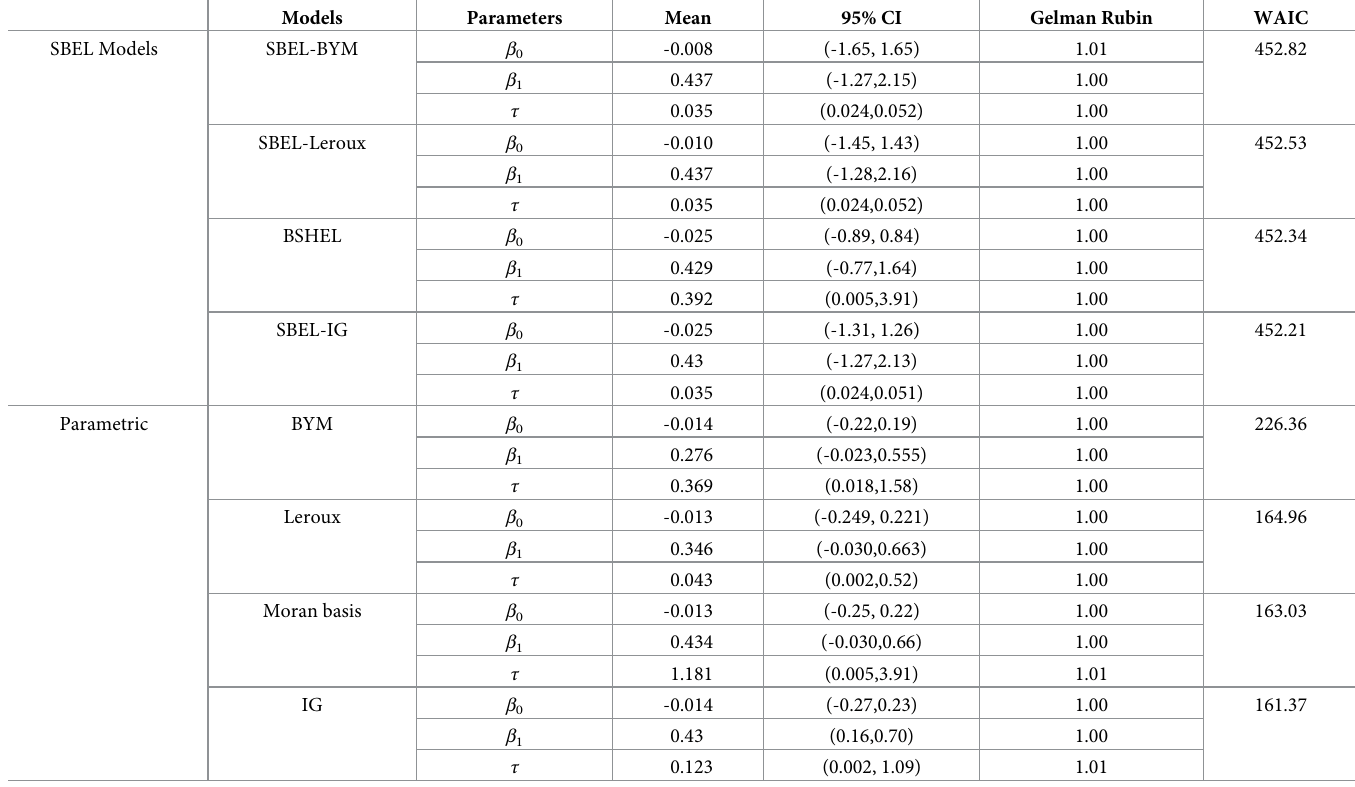
Table 1. Posterior summaries of regression coefficients ( β ) and precision parameter ( τ ) for Scottish lip cancer data using Bayesian parametric and semi-parametric models.